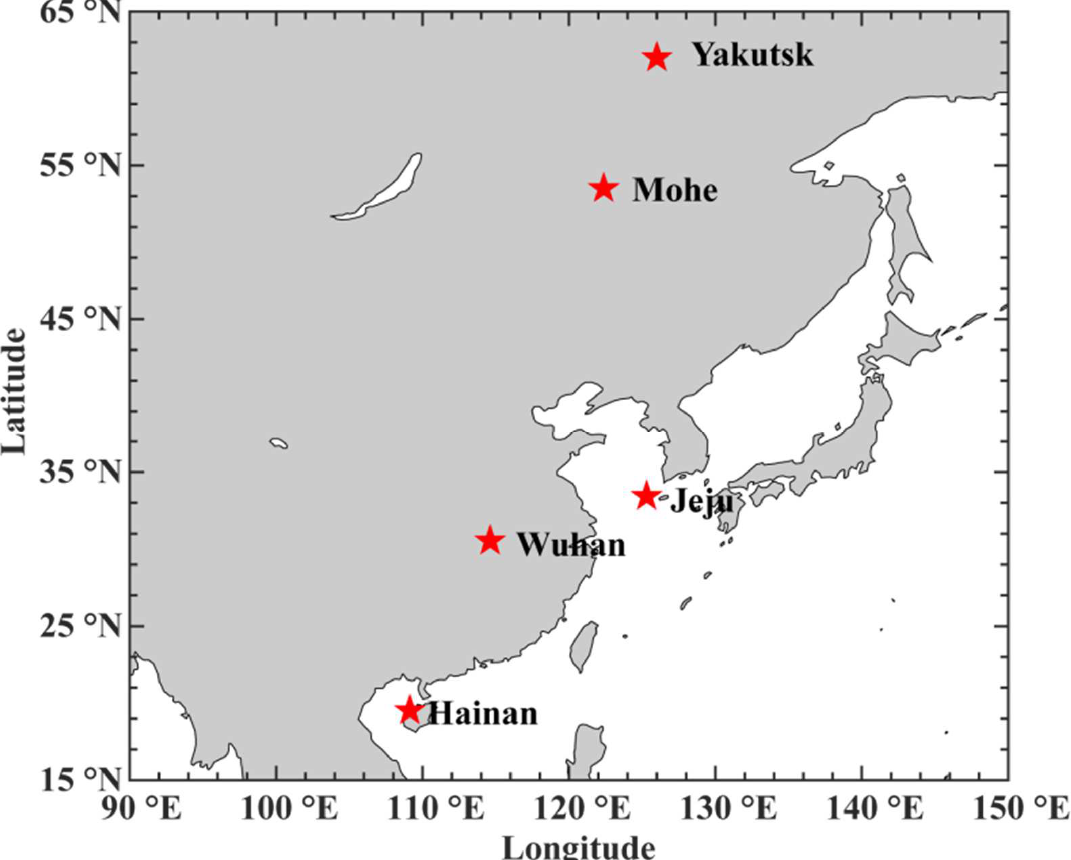
Figure 1. Geographical distribution of Yakutsk, Mohe, Jeju, Wuhan and Hainan